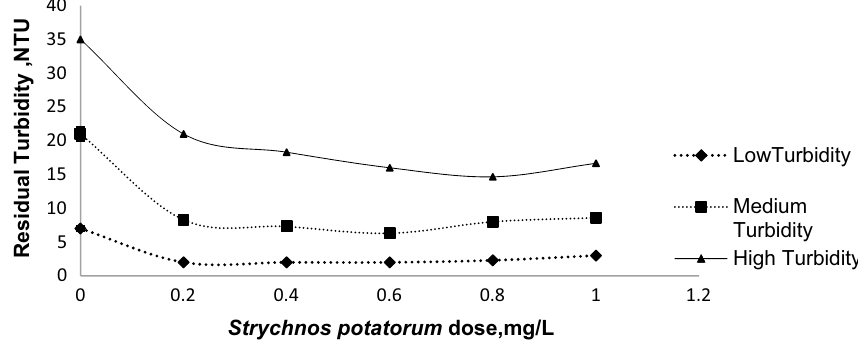
Fig. 5 Turbidity removal by Strychnos potatorum seed in (1) low, (2) medium and (3) high turbidity water